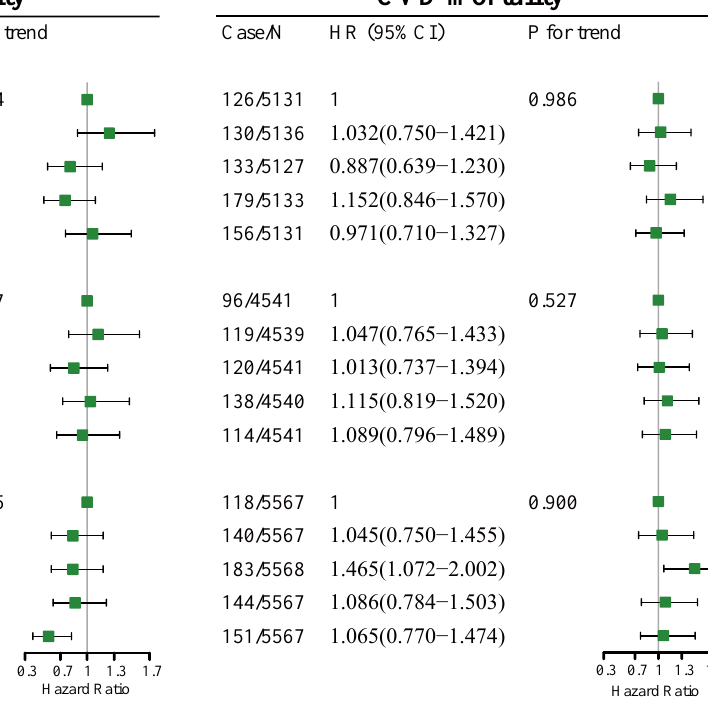
Figure 2. Multivariate adjusted HRs of dietary fiber intake at breakfast, lunch, and dinner with all-cause, cancer, and CVD mortality. Adjusted covariates in model 3 are based on model 1 with additional adjustment of total dietary fiber intake(low/high), energy intake at breakfast, lunch, and dinner, and residual fiber intake at breakfast, lunch, and dinner. Covariates in model 1 include age (5 categories); sex; classification of BMI; ethnicity; income; education level; smoking and drinking status; regular exercise; nutrient supplement use; total intake of energy (10 categories); percentage of energy provided by protein, fat, and carbohydrates; AHEI (10 categories); the prevalence of diabetes, hypertension, and hyperlipidemia; and medication use for glucose or blood pressure or blood lipids. BMI, body mass index; AHEI, Alternative Healthy Eating Index; CVD, cardiovascular disease; Case/ n , number of case participants/total; Q, Quintile; HR, hazard ratio.